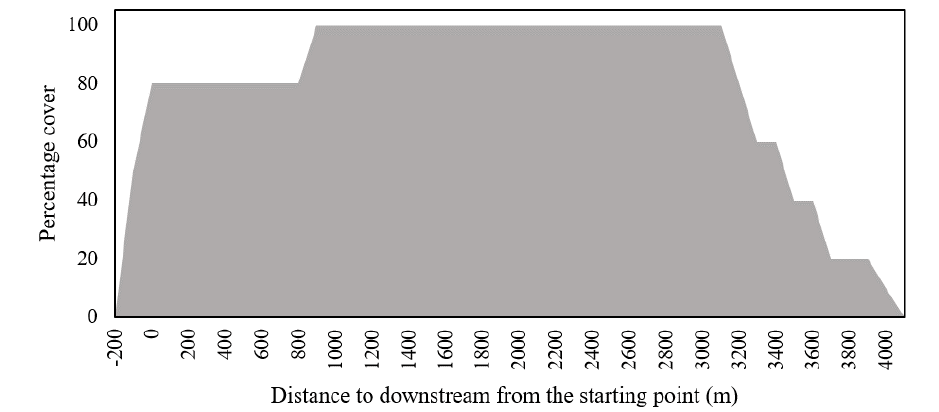
Figure 6: The percentage cover of C . furcata along the mainstream as visualized on the surface. The starting point of collecting data is denoted by the 0 (m).